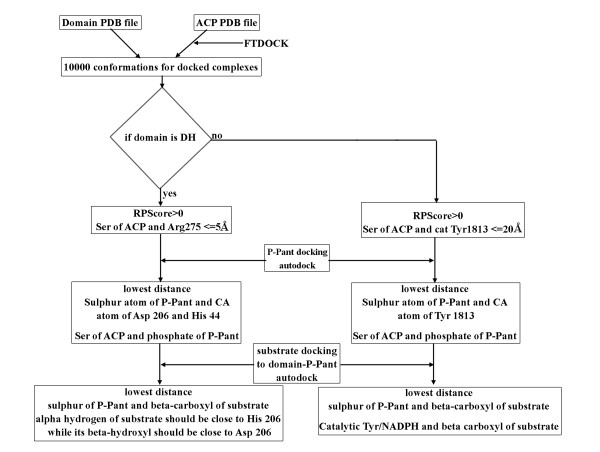
Protocol forin silicomodeling of substrate bound holo ACP-DH and holo ACP-KR complexes.